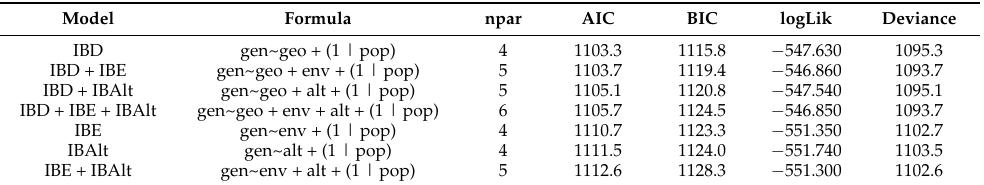
Table 2. Summary results of model selection in MLPE. The models are listed in order of AIC value; the IBD model has the best